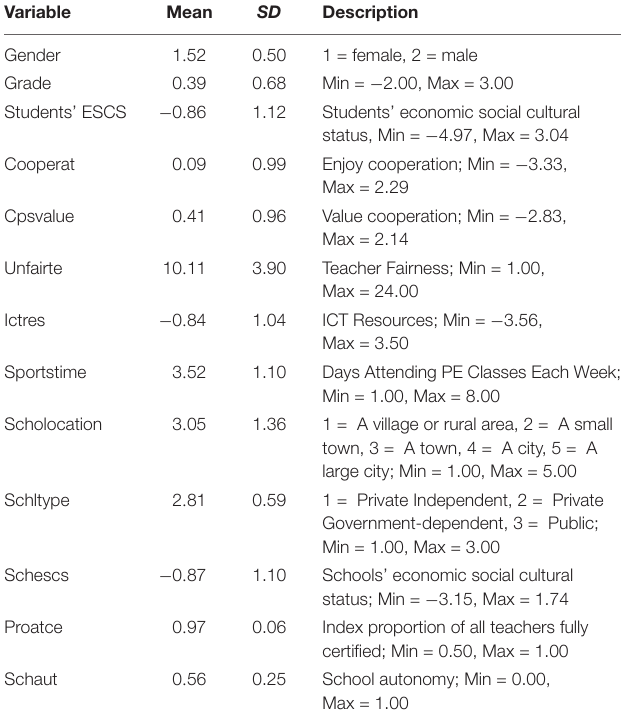
TABLE 2 | Descriptive statistics of independent